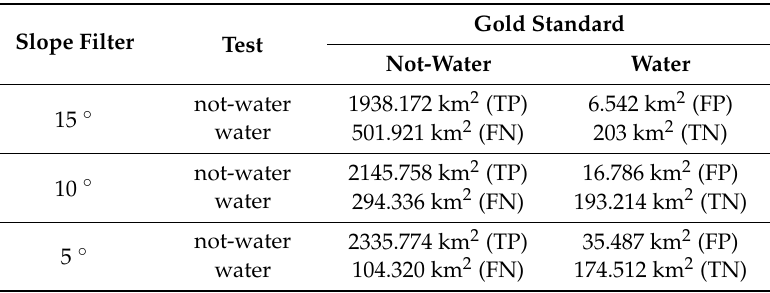
Table 2. Gold standard test for different filters (Valley County, Idaho).